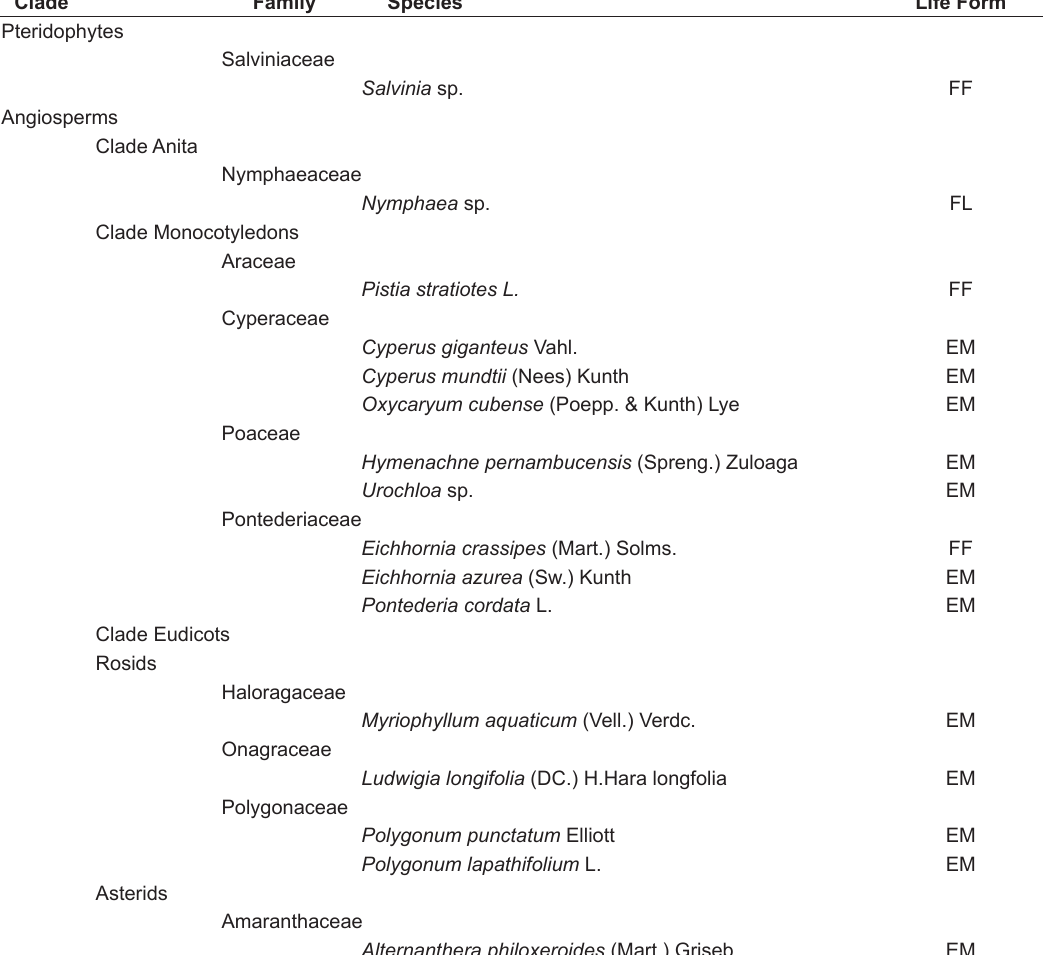
Table 1. Species checklist, families and life forms of macrophytes from the Itupararanga Reservoir in the summer (February, 2010) and in the winter (June, 2010).